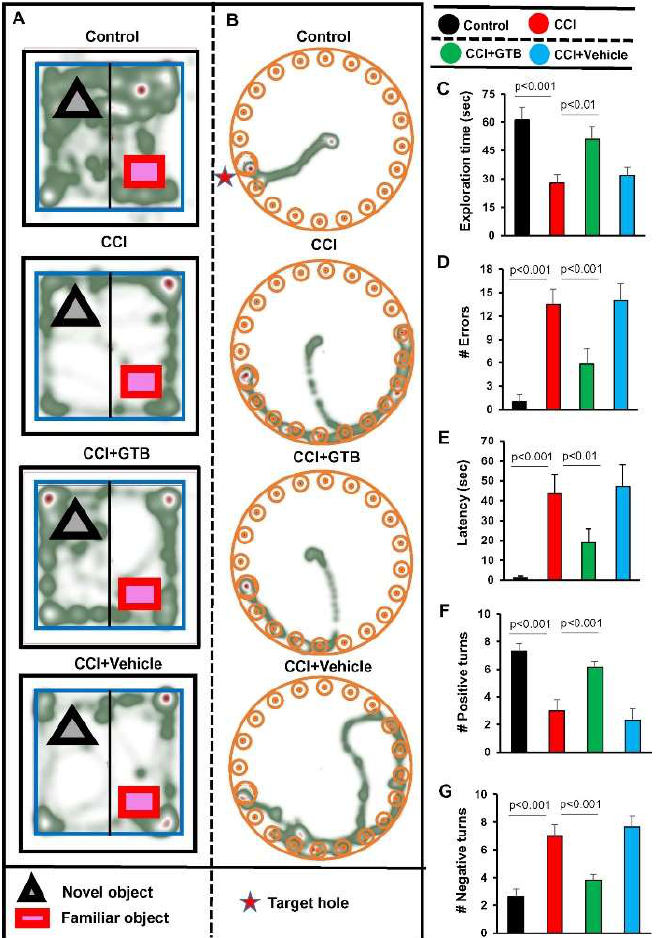
Figure 5. Effect of GTB on spatial learning and memory in TBI mice. TBI was induced in mice by CCI injury and after 24 h of injury, mice were treated with 50 mg/kg/day of GTB via oral gavage. Twenty-one days after CCI injury, mice were tested by novel object recognition test (( A ), Heat map; ( C ), Exploration time), Barnes maze (( B ), Heat map; ( D ), number of errors; ( E ), latency or time taken) and T-maze (( F ), positive turns; ( G ), Negative turns). Six mice were used in each group. Statistical analyses were performed by one-way ANOVA followed by Tukey’s post hoc test.